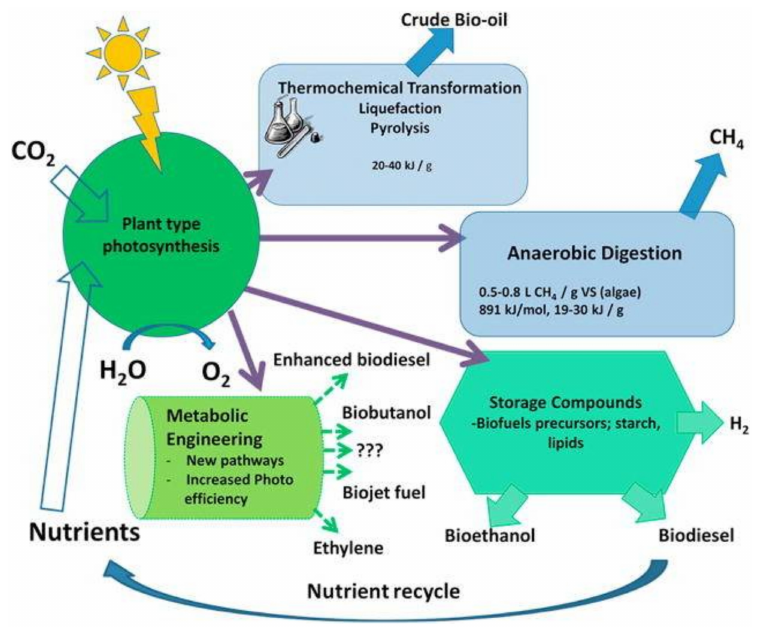
Figure 1. Renewable energy production based on microalgae biomass production. Reprinted with permission from Hallenbeck et al. [5], Copyright 2016, with permission from